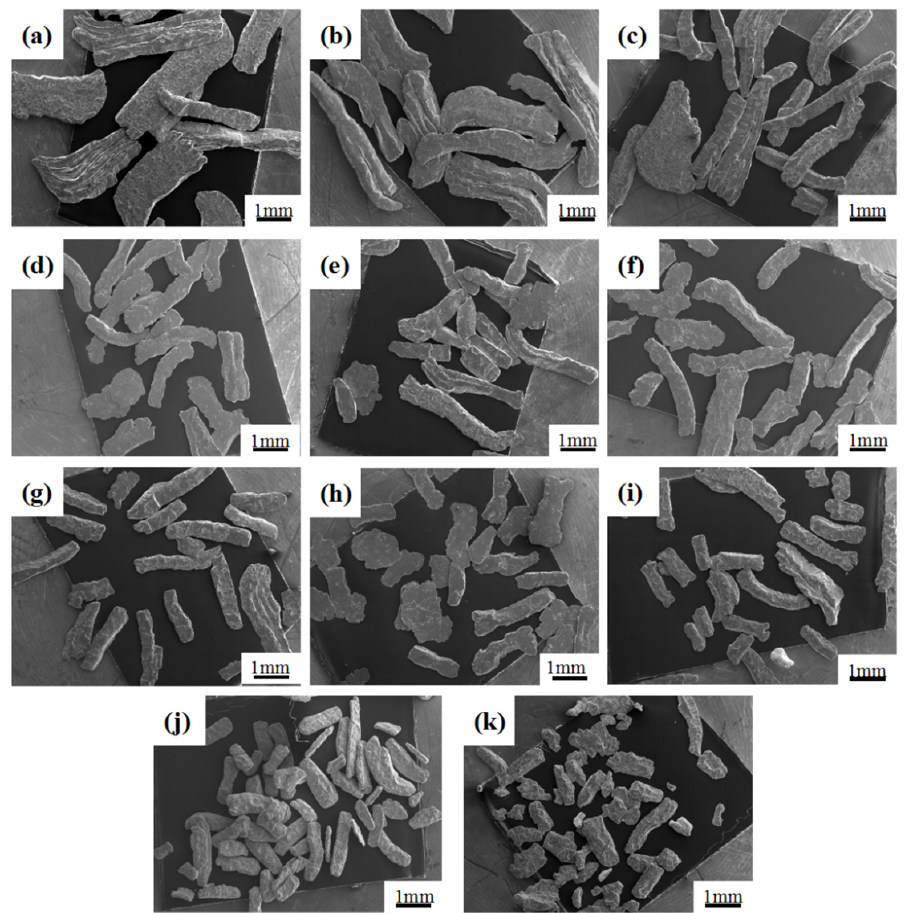
ff erent milling